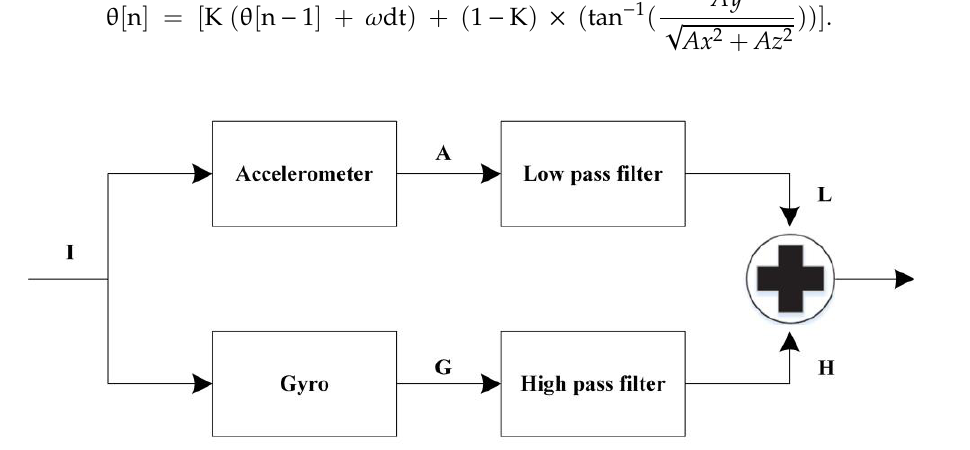
Figure 8. Conventional complementary